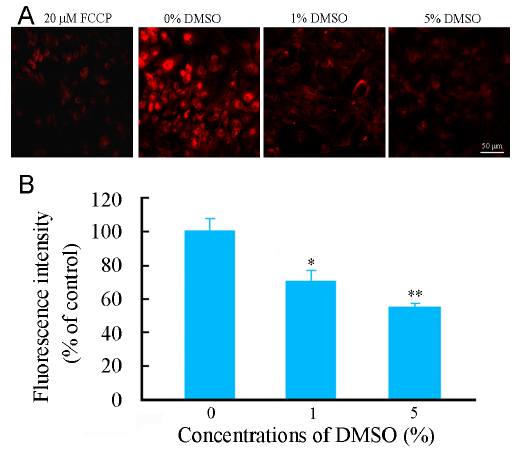
Figure 3. Effects of DMSO on DY m of cultured mouse cortical astrocytes. ( A ) Representative micrographs showing DY m, revealed by TMRE fluorescent staining, in astrocytes treated with various concentrations of DMSO for 24 h. The left first micrograph is a positive control for depolarized mitochondria by incubated with 20 m M FCCP, an uncoupler of electron transport and oxidative phosphorylation, for 10 minutes prior to staining with TMRE. ( B ) The quantitative analysis revealed that TMRE fluorescence intensity was decreased in astrocytes treated with DMSO in a dose-dependent manner. Data are shown as a mean 6 SEM of five independent experiments performed in triplicate. * P , 0.05 and ** P , 0.01 versus control group.